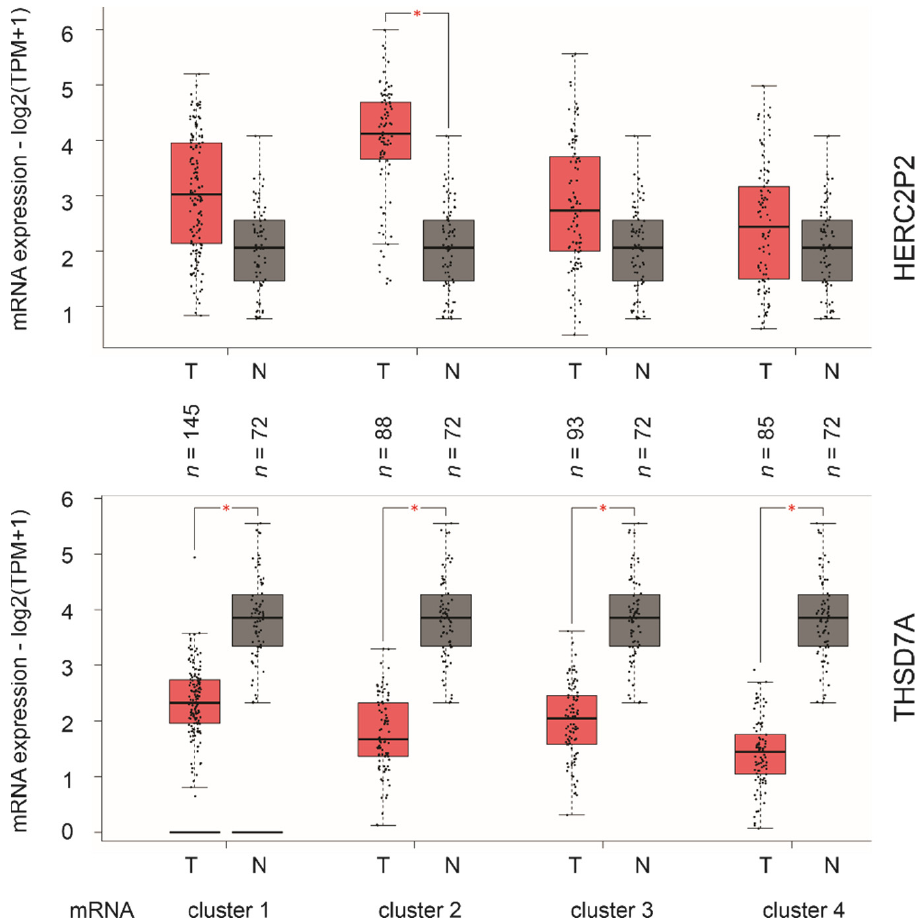
Figure 8. Differential expression of the HERC2P2 and THSD7A component genes in ccRCC (Tumor/T) and matched non-tumor kidney tissues (N). Gene expression was determined by RNA-seq (TCGA) and analyzed using the GEPIA2 program. Four mRNA clusters are indicated. TPM, transcripts per million. Statistical analyses were performed by GEPIA2, * p < 0.05.